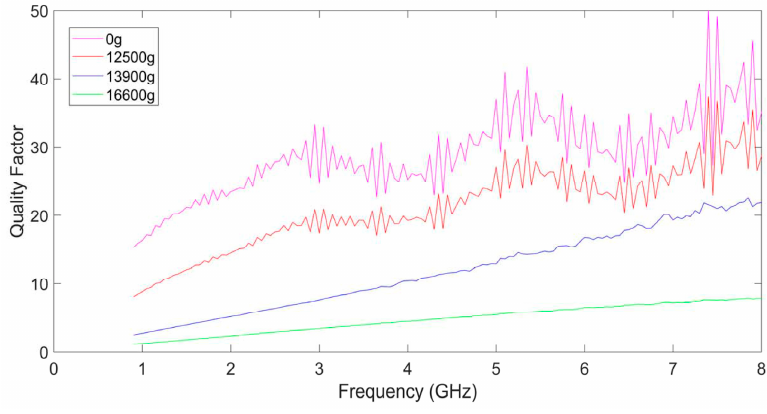
Figure 11. De-embedded quality factors of the inductors.